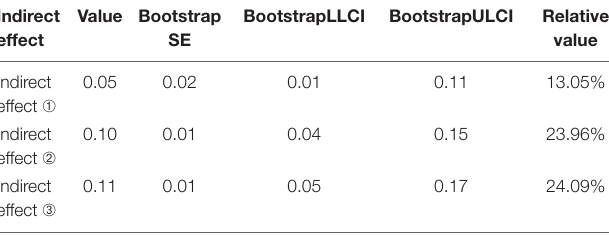
TABLE 2 | Bootstraping analysis of the mediating